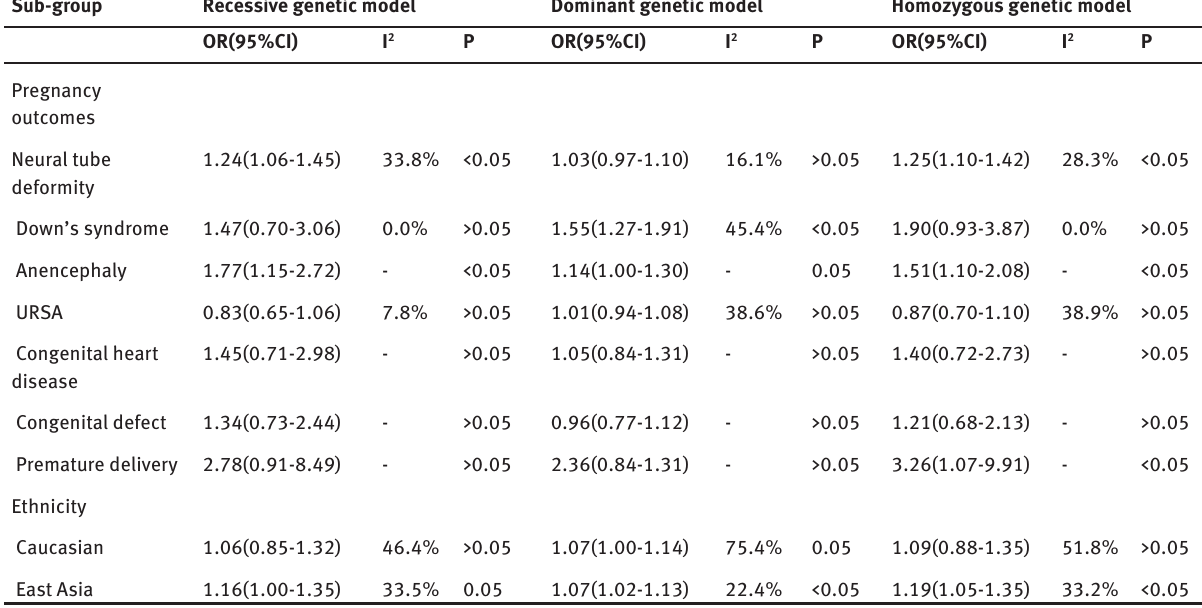
Figure 5: Begg’s funnel plot for evaluation of the (MTHFR) gene 677C > T polymorphism and fetal congenital defects. (A: dominant genetic model; B: homologous genetic model; C: recessive genetic Table 2: Subgroup analysis of the correlation between the methylenetetrahydrofolate reductase 677C > T gene polymorphism and fetal congenital defects.